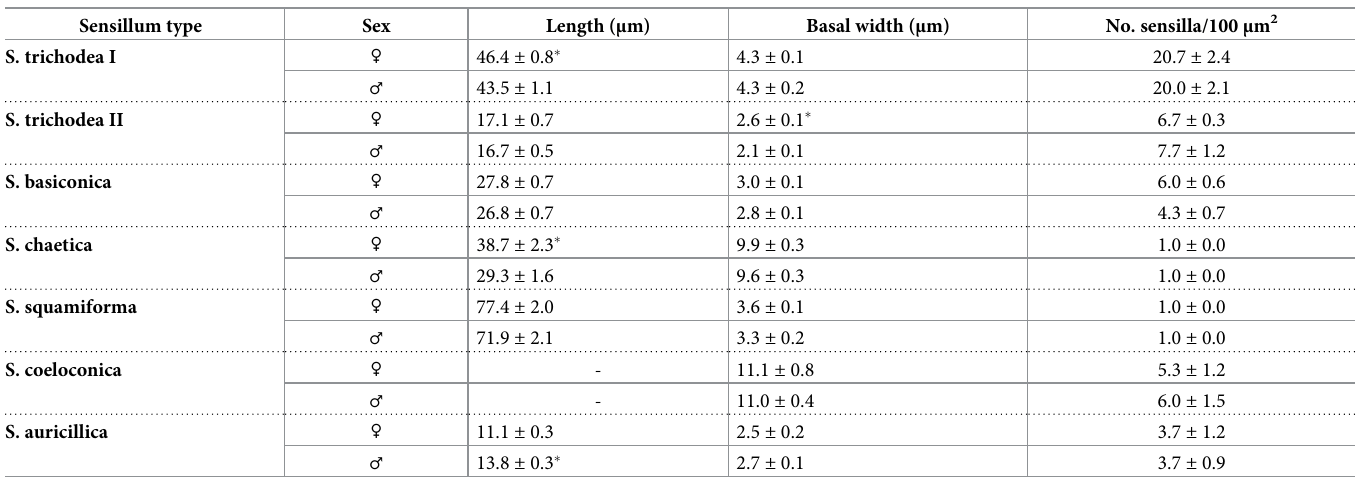
Table 2. Morphological features of male and female Telchin licus antennal sensilla.